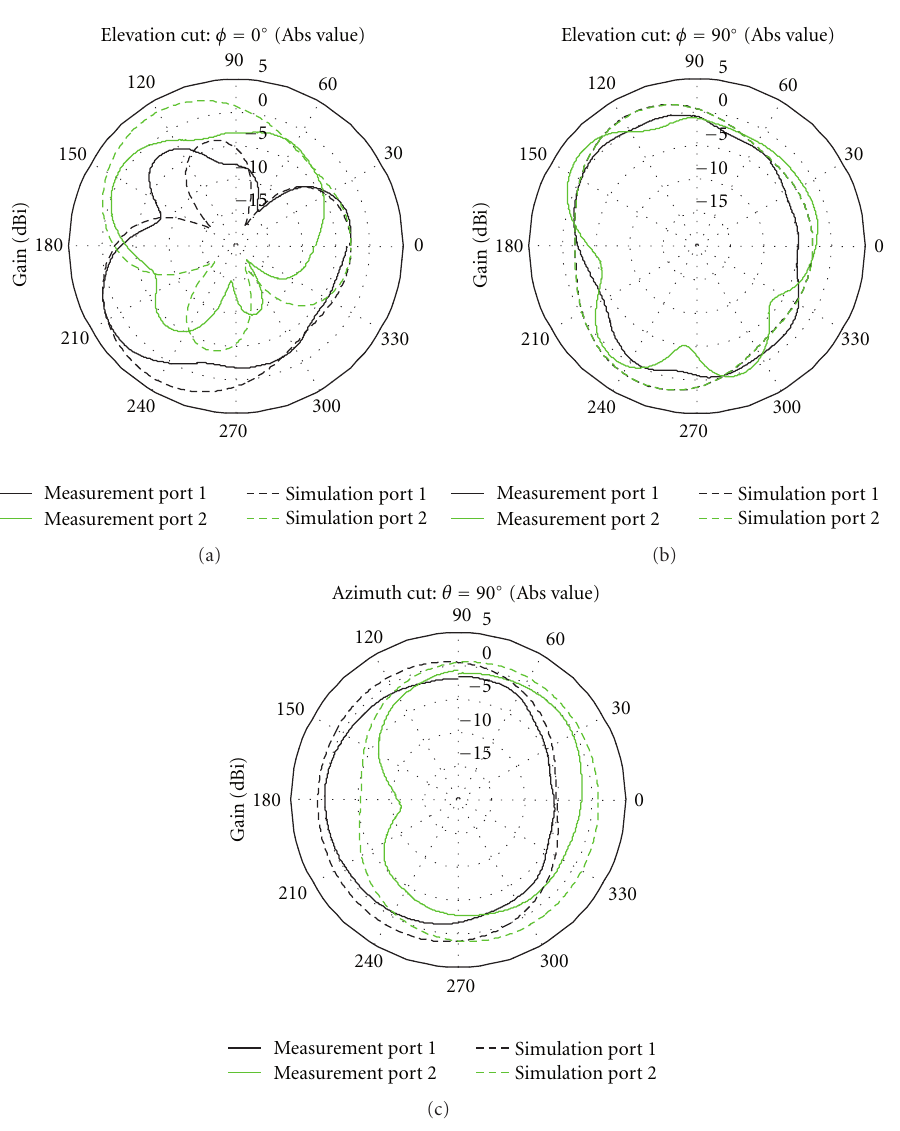
Figure 18: Radiation pattern cuts of the MIMO antenna system #3 (measurements versus